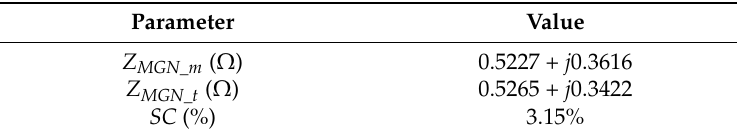
Figure 11. Results of the estimated g based on LSM. Table 4. Estimation results of Z MGN_m and SC .